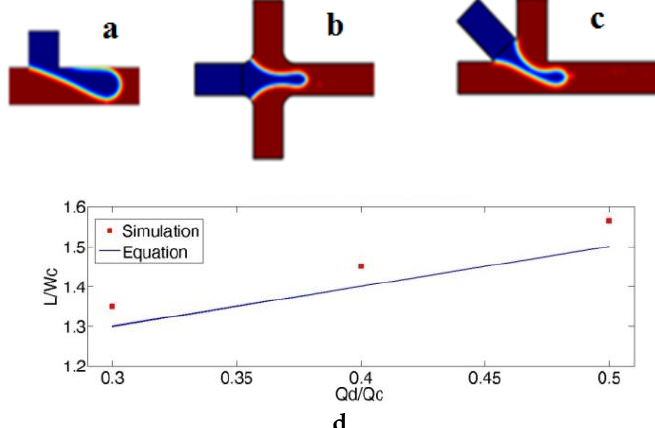
Figure 1. ( a – c ) photos show droplet break up region for the three channels geometry which recorded from simulation as follows: ( a ) Traditional T-Junction; ( b ) double T-junction (DTJ) channel; ( c ) modified double T-junction (MDTJ) channel. Blue is water and red is oil. ( d ) This graph illustrates the error between simulated T-Junction channel and Equation (8).